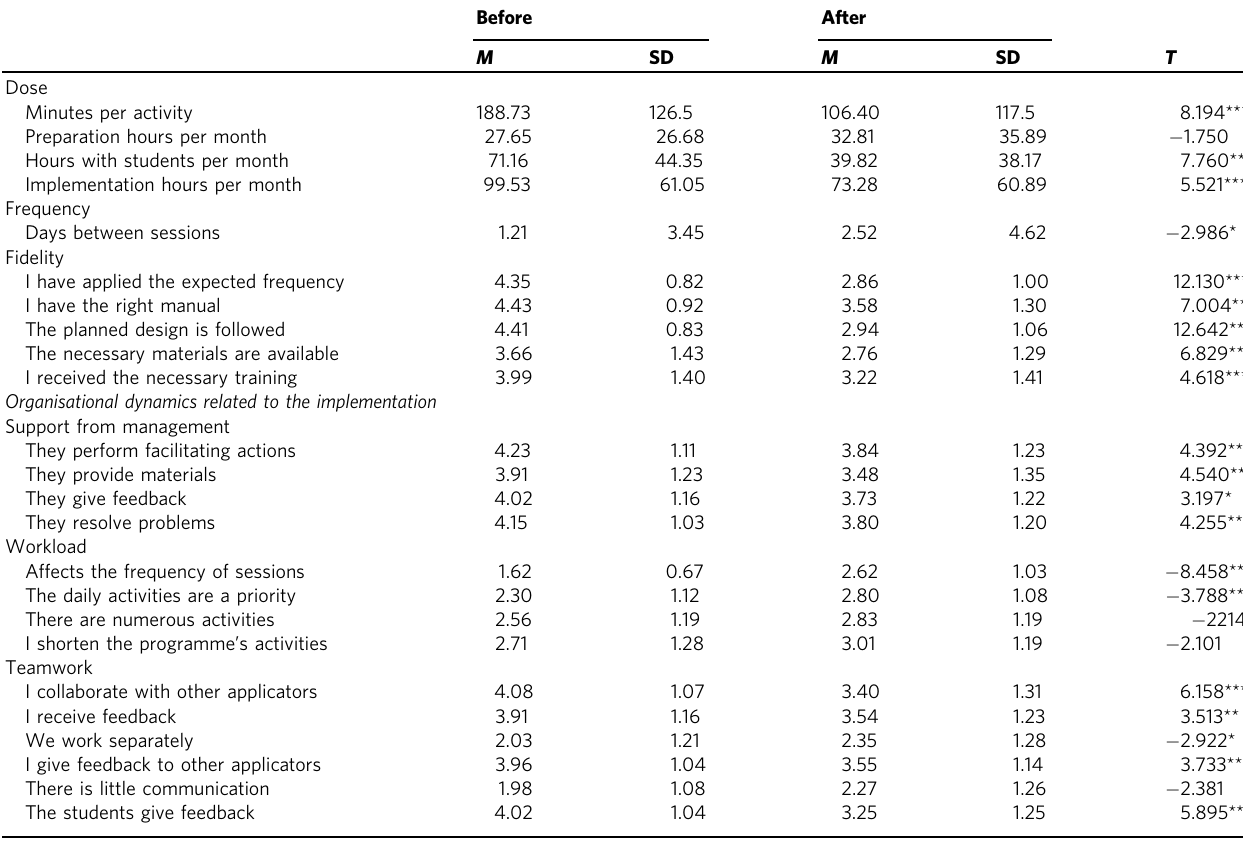
Table 2 Comparison of the implementation of the programme before and after con fi nement ( n = 102).